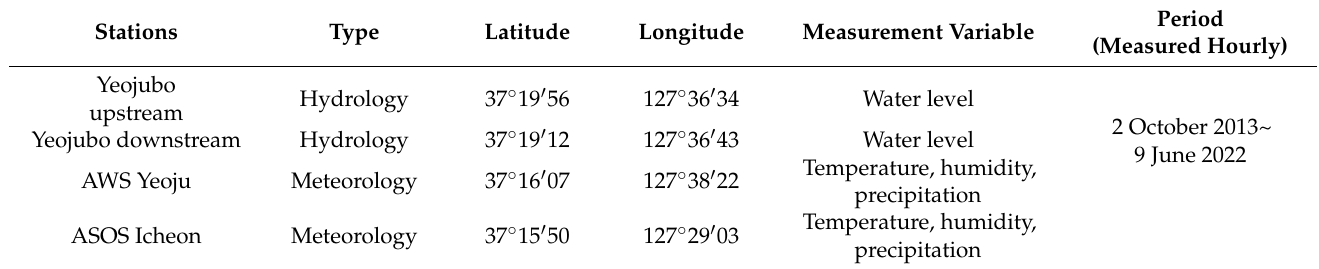
Table 1. Information of meteorological station and hydrological